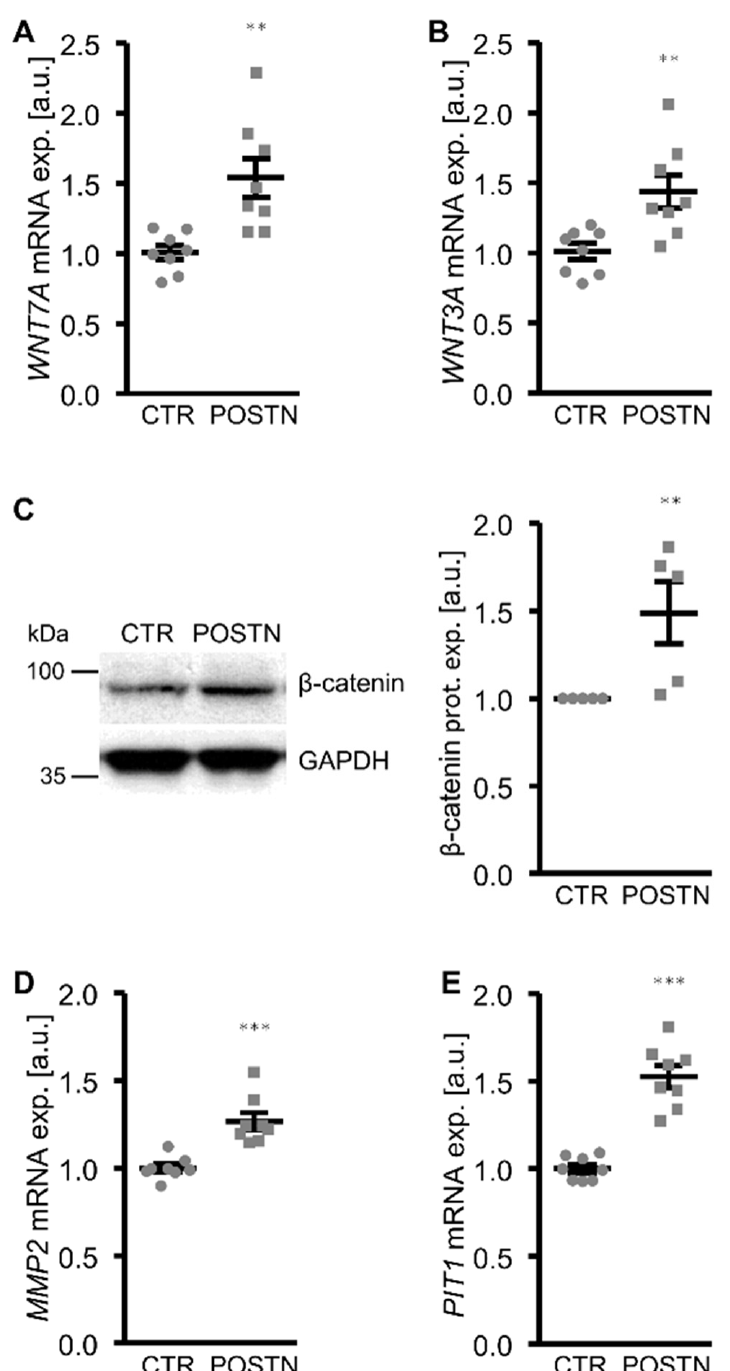
Figure 3. Periostin increases WNT/ β -catenin signaling in HAoSMCs. ( A , B ) Relative mRNA expres- sion of WNT7A ( A ) and WNT3A ( B ) in HAoSMCs treated with control (CTR) or recombinant human periostin (POSTN). ( C ) Representative Western blots and normalized β -catenin protein expression in HAoSMCs treated with control (CTR) or recombinant human periostin (POSTN). ( D , E ) Relative mRNA expression of MMP2 ( D ) and PIT1 ( E ) in HAoSMCs treated with control (CTR) or recombinant human periostin (POSTN). ** p < 0.01; *** p < 0.001 (significant difference versus CTR group).